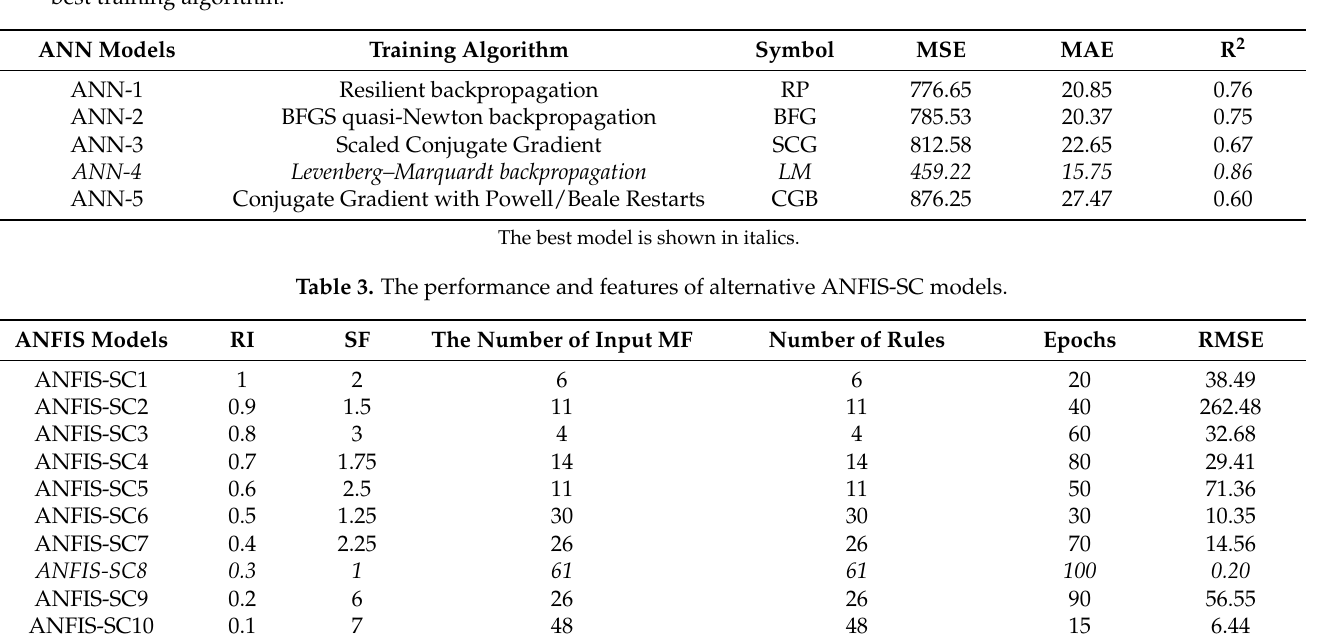
Table 2. MSE, MAE, and R 2 of the five ANN models executed with five neurons in the hidden layer architecture to find the best training algorithm.